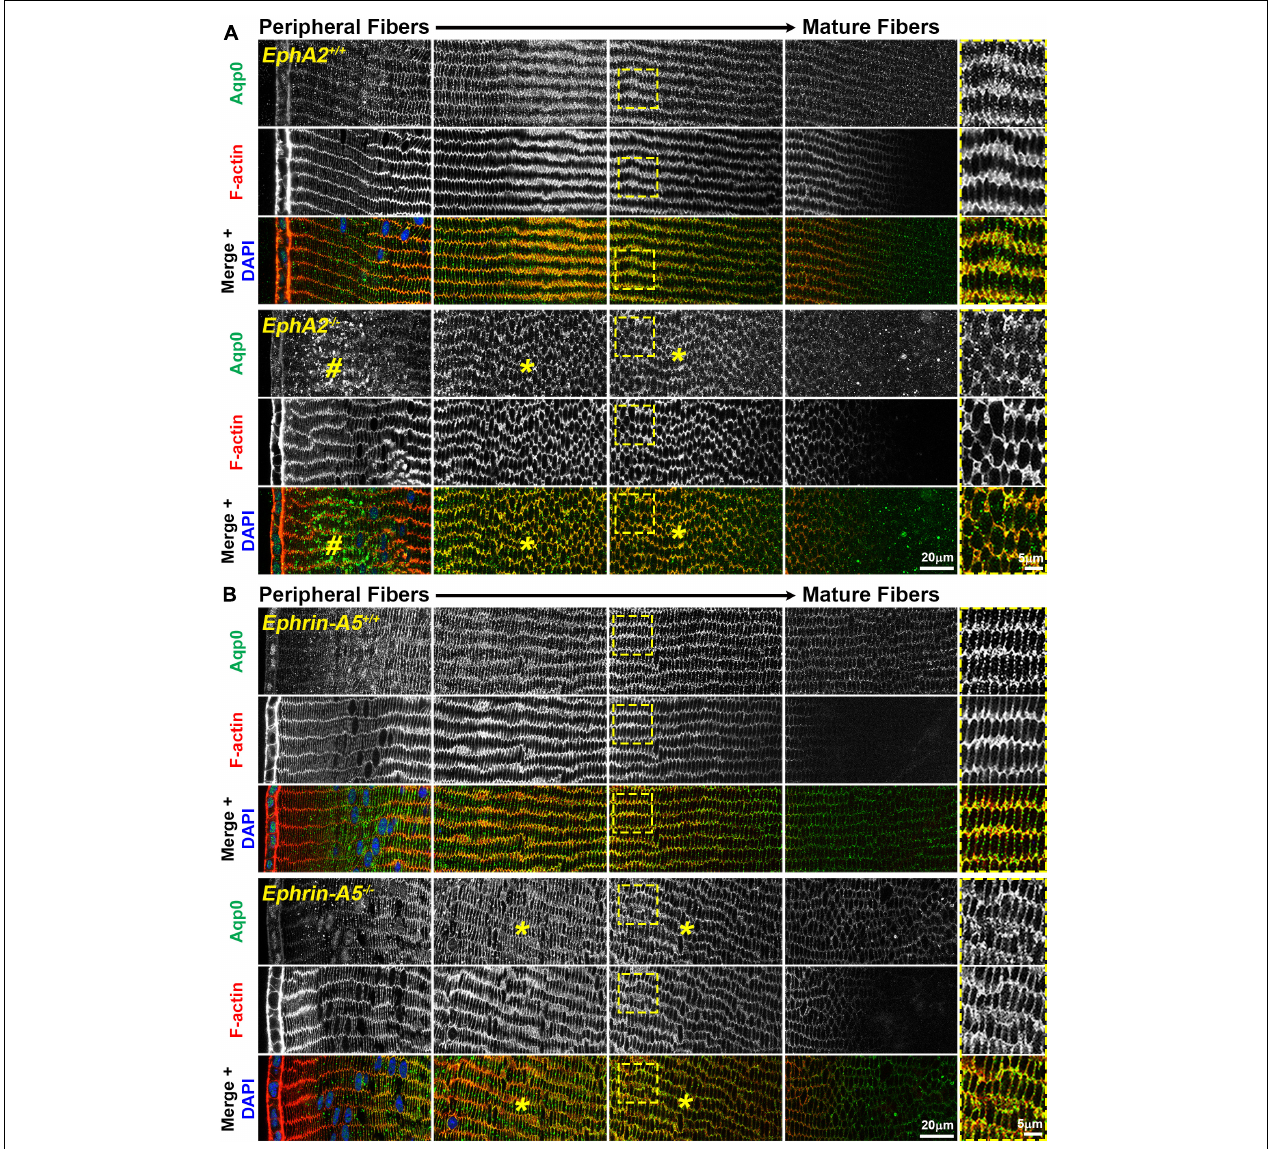
FIGURE 3 | Aquaporin 0 (Aqp0, green) and phalloidin (F-actin, red) staining in cross sections from control, EphA2 − / − and ephrin-A5 − / − lenses. Images are from the periphery to the inner mature fiber cells of the lens. (A) In control peripheral lens fibers, Aqp0 is added to the cell membrane and evenly distributed around the membrane. As the cells mature, Aqp0 is enriched on the short sides of the fiber cells. In EphA2 − / − peripheral fiber cells, there are large puncta/aggregates of Aqp0 (pound signs), and as the cells mature, Aqp0 is distributed around the cell membrane without enrichment along the short sides of the cells (asterisks and high magnification panels on the right). (B) Compared to control fibers, Aqp0 distribution in differentiating and maturing ephrin-A5 − / − fibers is around the entire cell membrane (asterisks and high magnification panels on the right) while Aqp0 is enriched along the short sides of control lens fibers. Scale bars, 20 and 5 µ m.